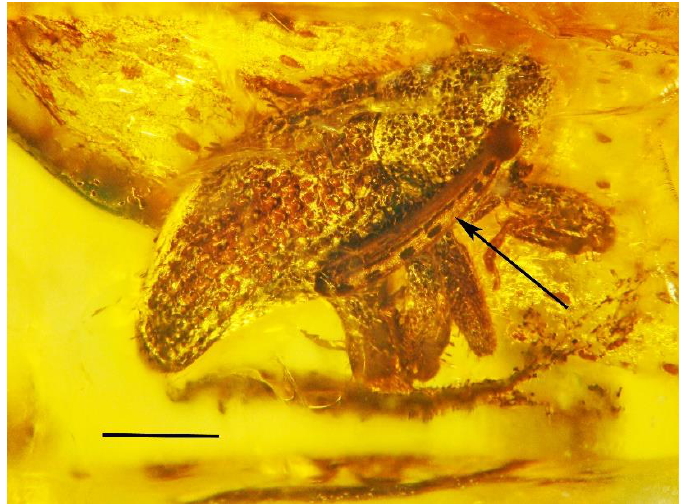
Figure 26. Cryptorhynchid weevil (Coleoptera: Curculionidae) with attached orchid pollinarium (arrow) of Cyclindrocites browni (Angiospermae: Orchidaceae) in Dominican amber. Scale bar = 1.0 mm.